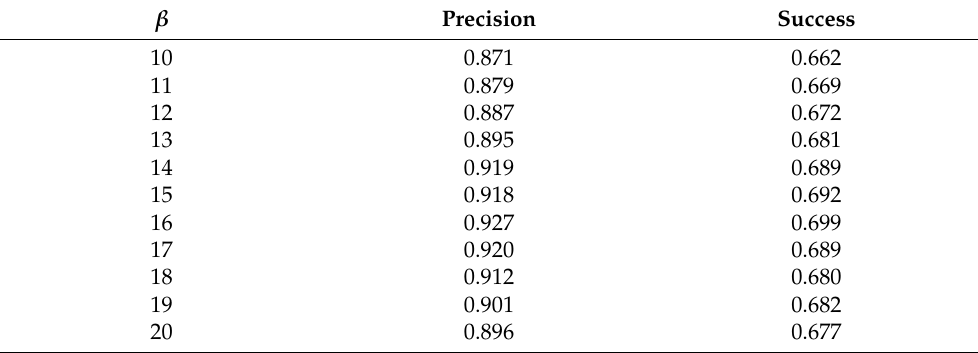
Figure 8. Representative tracking results of qualitative evaluation. The selective sequences are Bird1, Skiing, Soccer, Coke, Freeman4, Singer2, and Ironman. Table 5. Precision and success rates on OTB2015 dataset with different temporal-aware regularization parameters β